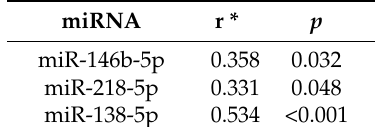
Table 4. Correlation analysis between miRNA and DFS.